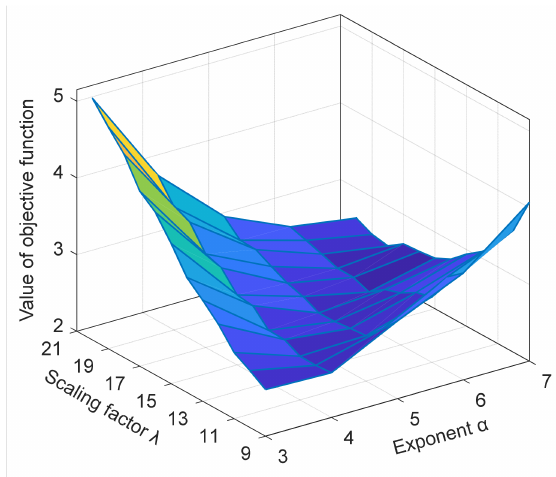
Figure 6. Correlation comparison of the different exponents and scaling